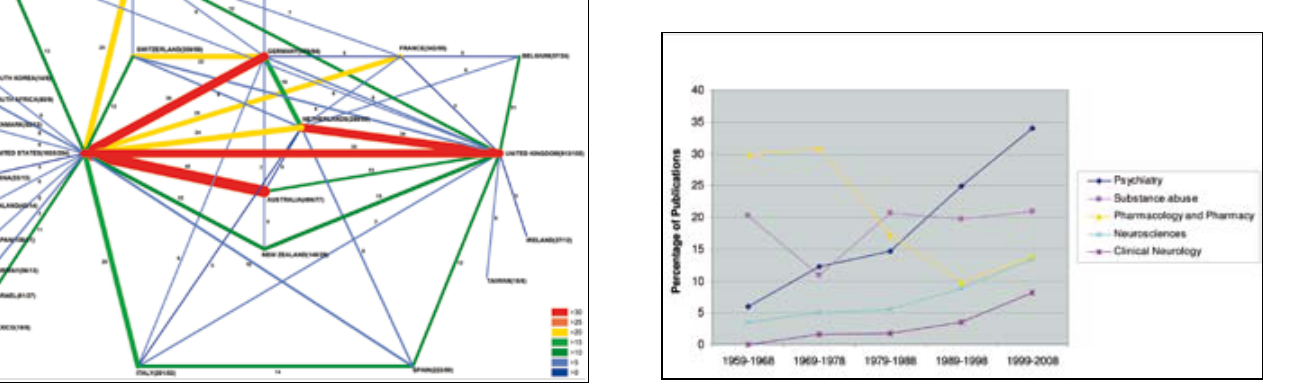
Fig. 5. Comparison of countries with at least five collaborative publications. Format: country (amount of publications/ amount of publications in co-operation with other countries).